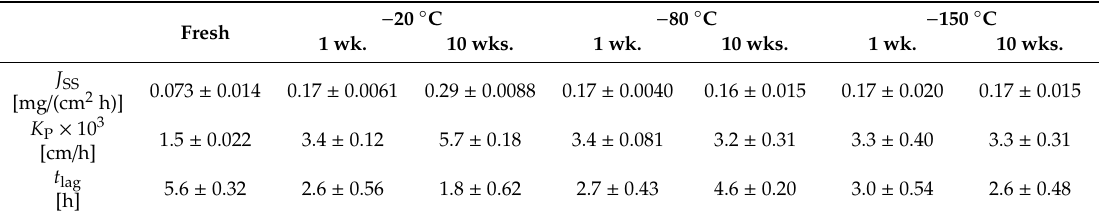
Table 3. Steady-state fluxes, permeability coe ffi cients and lag times of resorcinol permeated through fresh and frozen EpiSkin ™ RHE (mean ± SD).